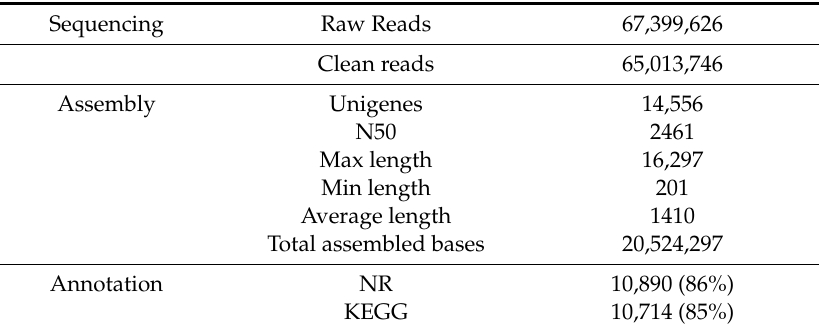
Figure 1. Di ff erentiating characteristics of V. volvacea strains v26 and v9. ( A ) The “egg” stage in the development of V. volvacea . Note that the v26 fruiting body is oval-shaped, whereas v9 is bell-shaped. ( B ) Mycelial growth rates of V. volvacea strains v26 and v9. ( C ) The biological e ffi ciency of v26 and v9. Both strains were cultivated on rice straw and cotton waste. ( D ) Developmental periods of v26 and v9. Strain v9 developed faster than v26. Each experiment was repeated three times. Mycelial growth rates, biological e ffi ciency and developmental stages time were carried out by a Student’s t test. The mycelial growth rates, biological e ffi ciency and egg stage time were significantly di ff erent ( p < 0.05, The elongation stage and mature stage developmental time were not significantly di ff erent ( p > 0.05). Bar = 1 cm in ( A ). Data are presented as the average ± SD in ( B – D ).